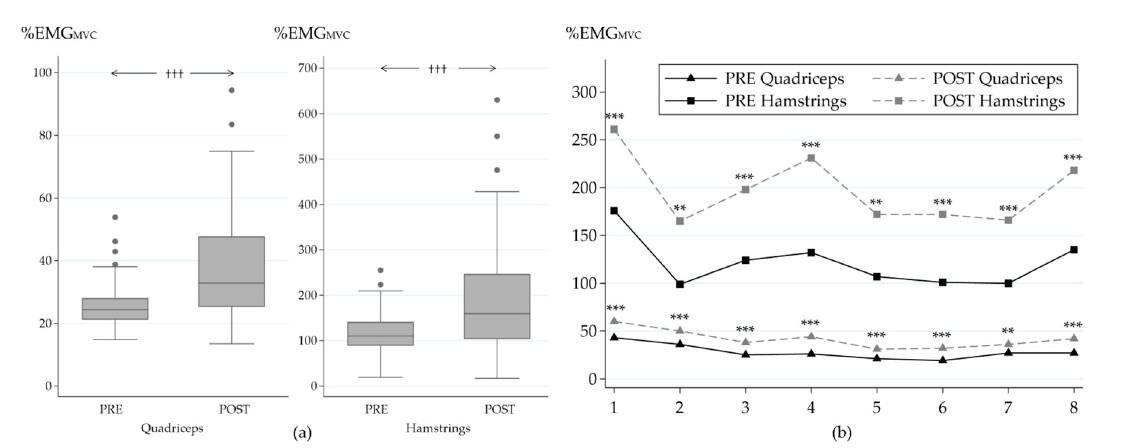
Figure 5. Average normalized muscle activity of the quadriceps and hamstrings muscles during MST ( a ) and during the individual tasks of MST ( b ) in the beginning (PRE) and at the end (POST) of the study. Significance of change between PRE and POST: ††† p ≤ 0.001 (Wilcoxon signed rank test); ** p ≤ 0.01; *** p ≤ 0.001 (Student´s paired t-test). MST tasks: 1, rushes; 2, low crawl; 3, sprint; 4, hurdles; 5, kettle bell carry; 6, zig zag run; 7, casualty drag; 8, 90-degree sprint.